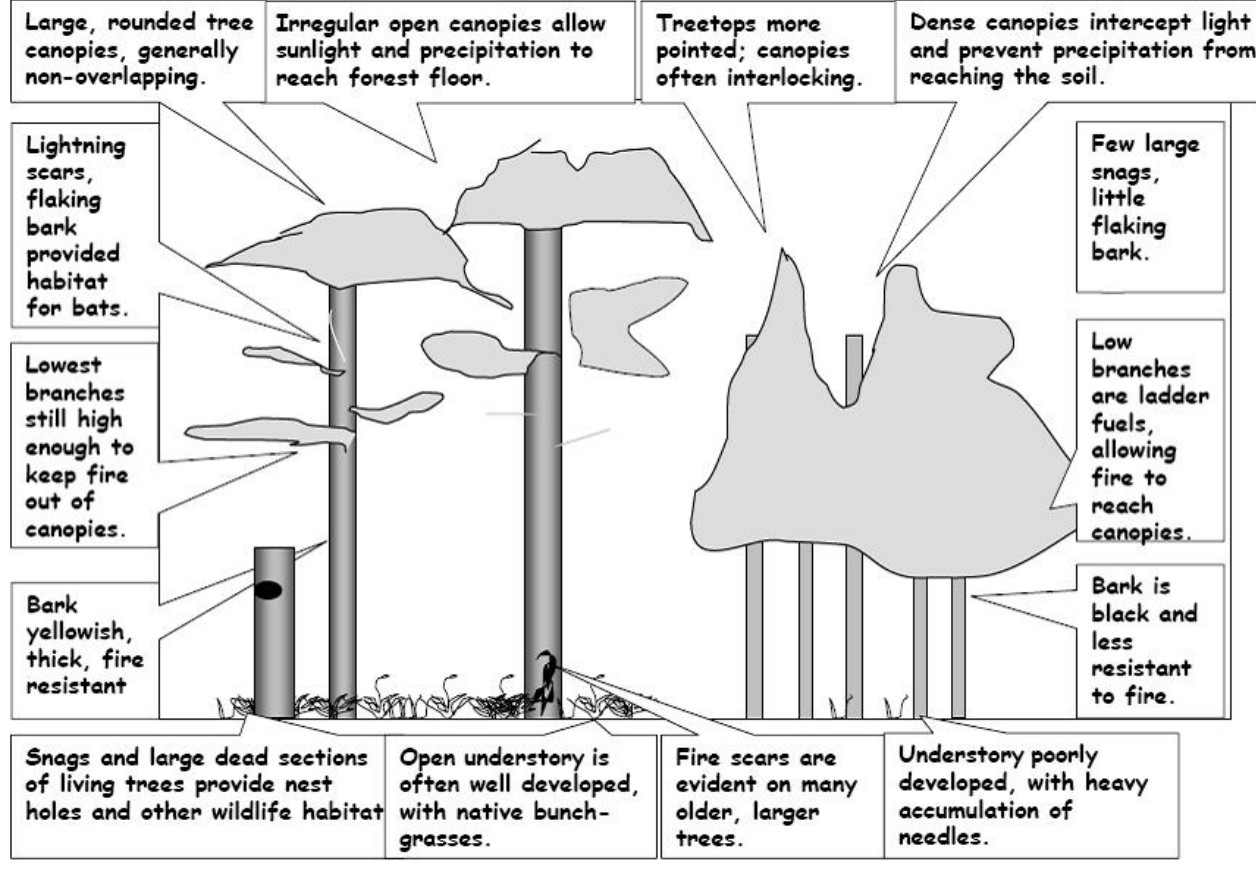
Fig. 1. A cartoon description of the key features of old-growth forests in frequent-fire landscapes (left), in contrast to younger forests lacking fire